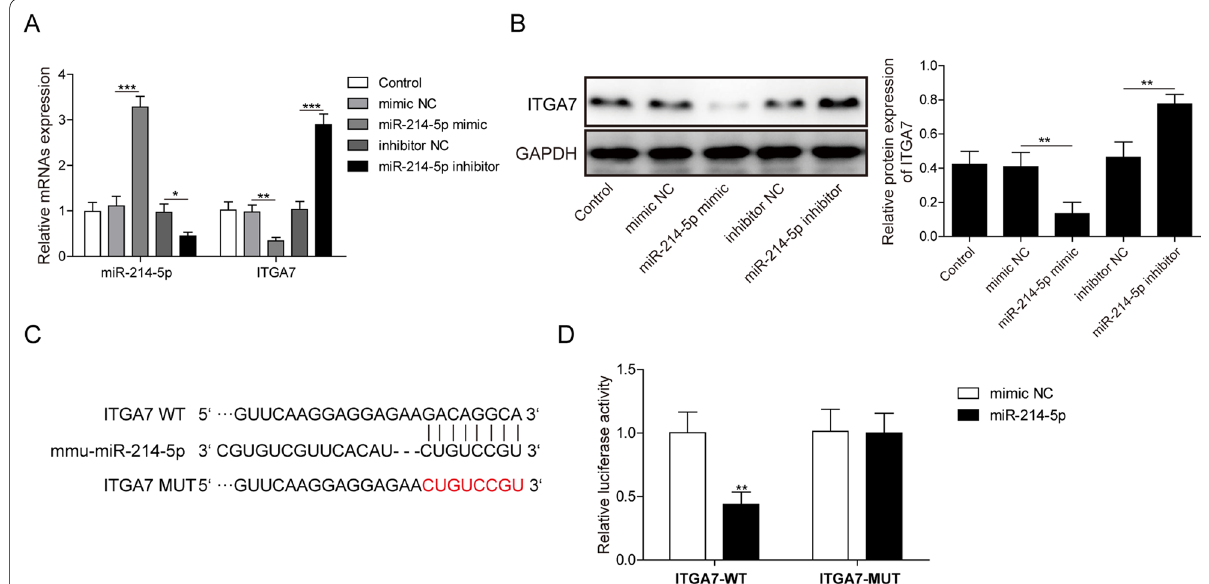
Fig. 4 MiR‑214‑5p directly interacts with ITGA7. Cells were treated with miR‑214‑5p mimic/mimic NC or inhibitor NC/ miR‑214‑5p inhibitor. A Expression of miR‑214‑5p and ITGA7 after different treatment was detected by qRT‑PCR. B Protein level of ITGA7 was detected by western blotting. C The possible binding site of miR‑214‑5p in the ITGA7 3 ′ ‑UTR. D Luciferase reporter assay in RAW264.7 cells transfected with a plasmid containing ITGA7 WT, ITGA7 MUT, miR‑214‑5p mimic/mimic NC. Experiments were performed for at least 3 times. Data are presented as